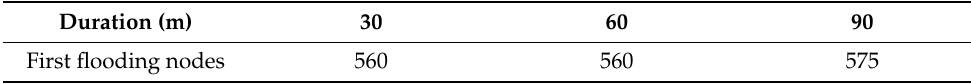
Table 3. Results of first flooding